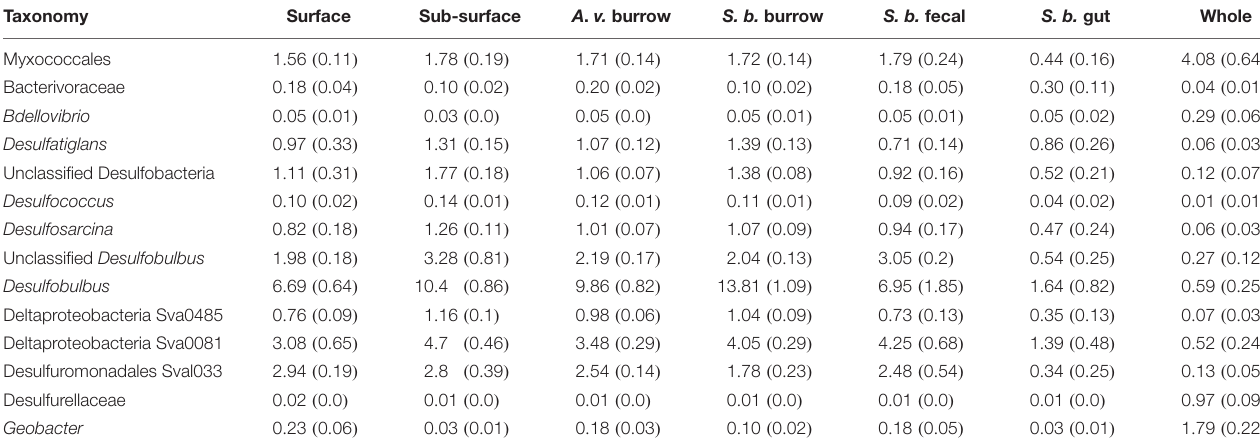
TABLE 2 | Major contributors to Deltaproteobacteria in surface, sub-surface, Alitta virens ( A . v .) burrows, Saccoglossus bromophenolosus ( S . b .) burrows, S. bromophenolosus fecal casts, S. bromophenolosus gut contents, and sediment-free whole S. bromophenolosus (Whole) microbial communities.